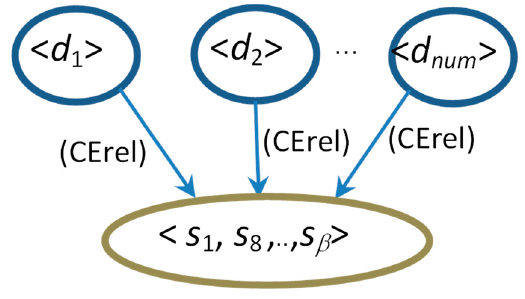
Figure 1. Present DSKG formed by several CErel connections on which each CErel connection links each < d i > node to a < s 1 , s 3 , ..., s β > node as an occurrence of multiple symptoms where s 1 , s 3 , ..., and s β are the correlated s c features ; d 1 --> s 1 ∧ s 2 ∧ s 8 … ∧ s β ; d 2 -->s 1 ∧ s 3 ∧ s 4 ∧ s 8 … ∧ s β ; …; d num --> s 1 ∧ s 5 ∧ s 8 … ∧ s β .